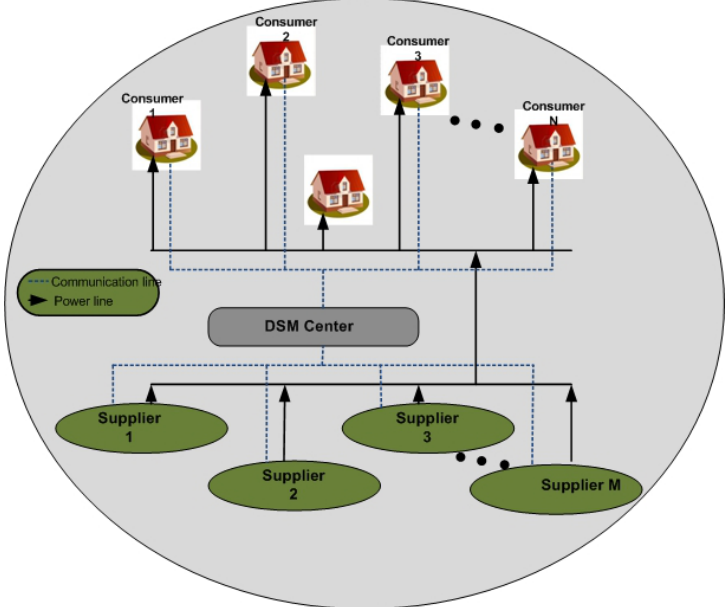
Figure 7. Game theory-based DSM